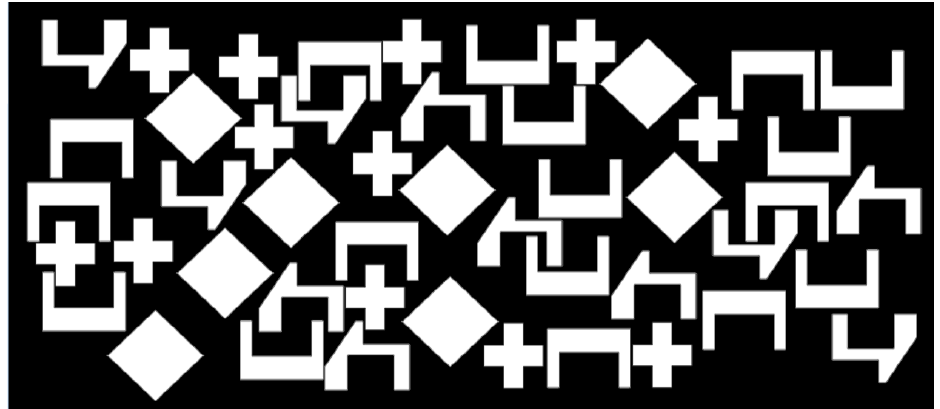
Figure 13. Solution found by the ILS algorithm inserting 48 pieces for the Shape 1 instance, consuming 2 h of processing time.